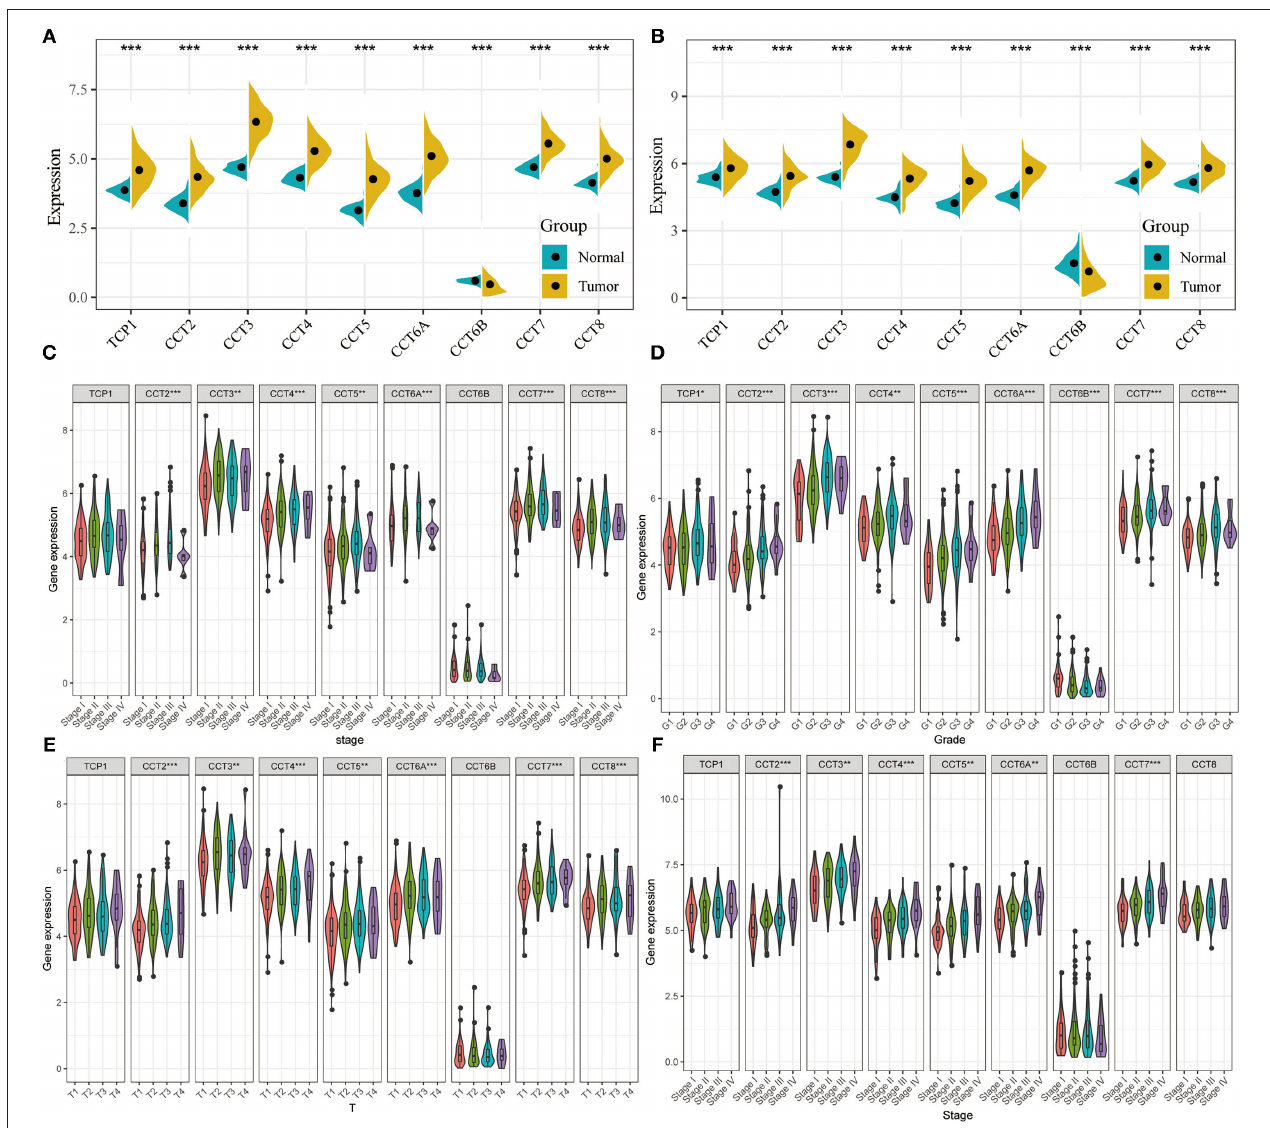
FIGURE 1 | Comparison of CCT subunit genes expression in the TCGA and ICGC cohorts. CCT subunits (TCP1, CCT2, CCT3, CCT4, CCT5, CCT6A, CCT6B, CCT7, CCT8) gene expression levels were compared between tumor and non-tumor tissues in HCC patients from TCGA (A) and ICGC (B) cohorts. Comparison of CCT subunit gene expression levels with low and high stage (C) , grade (D) and T stage (E) in TCGA and ICGC (F) cohort. TCGA, The Cancer Genome Atlas; ICGC, International Cancer Genome Consortium. * P < 0.05, ** P < 0.01, *** P <